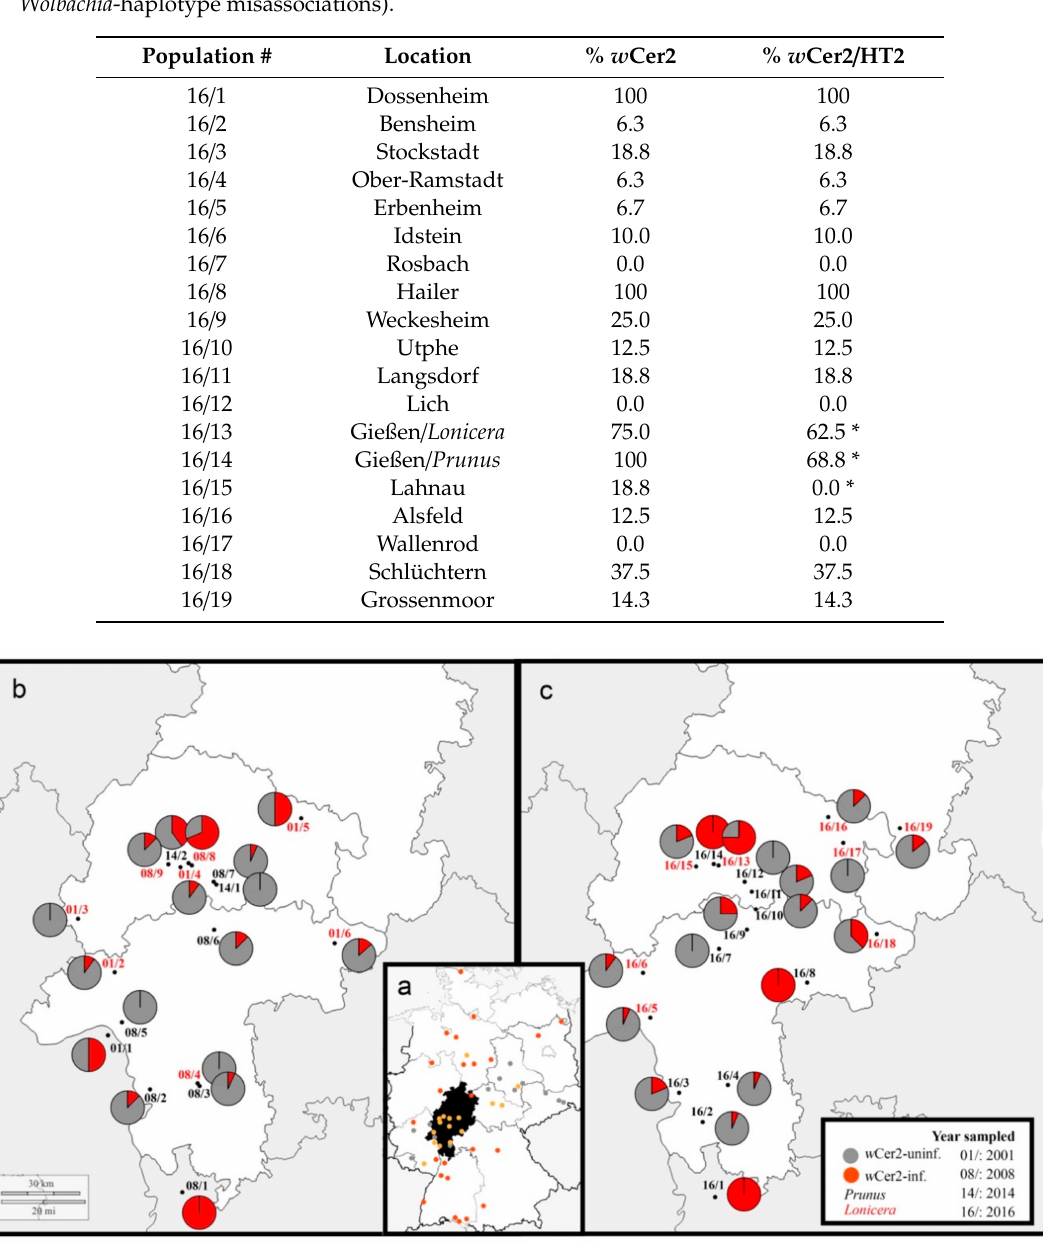
Figure 1. Geographic distribution of Wolbachia of R. cerasi : ( a ) Schematic overview of Wolbachia infections across Germany. Distribution of w Cer2-uninfected (grey dots), w Cer2-infected (red dots), and transitional populations with w Cer2-infected and w Cer2-uninfected flies (orange dots) sampled between 2000–2008, modified from [16]. Black-filled state represents Hesse, the central study site; ( b ) w Cer2 infection frequencies between 2001 and 2014 and ( c ) in 2016. Grey = proportion of w Cer2-uninfected flies, red = proportion of w Cer2- infected flies, black numbers represent flies collected from Prunus and red numbers represent flies collected from Lonicera